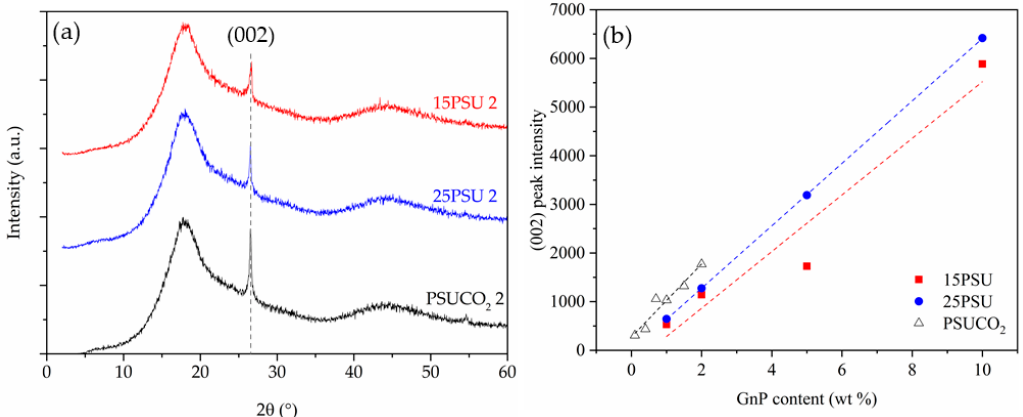
Figure 2. ( a ) XRD spectra of microcellular nanocomposites containing 2 wt% GnP with the presence of a characteristic (002) di ff raction plane of GnP at 2 θ = 26.5 and ( b ) the normalized intensity value of the (002) di ff raction plane of the GnP peak for PSU and PSU–GnP microcellular nanocomposites. The peak intensity was normalized by dividing the intensity by the density and presented using a linear fit with respect to the concentration of GnP.